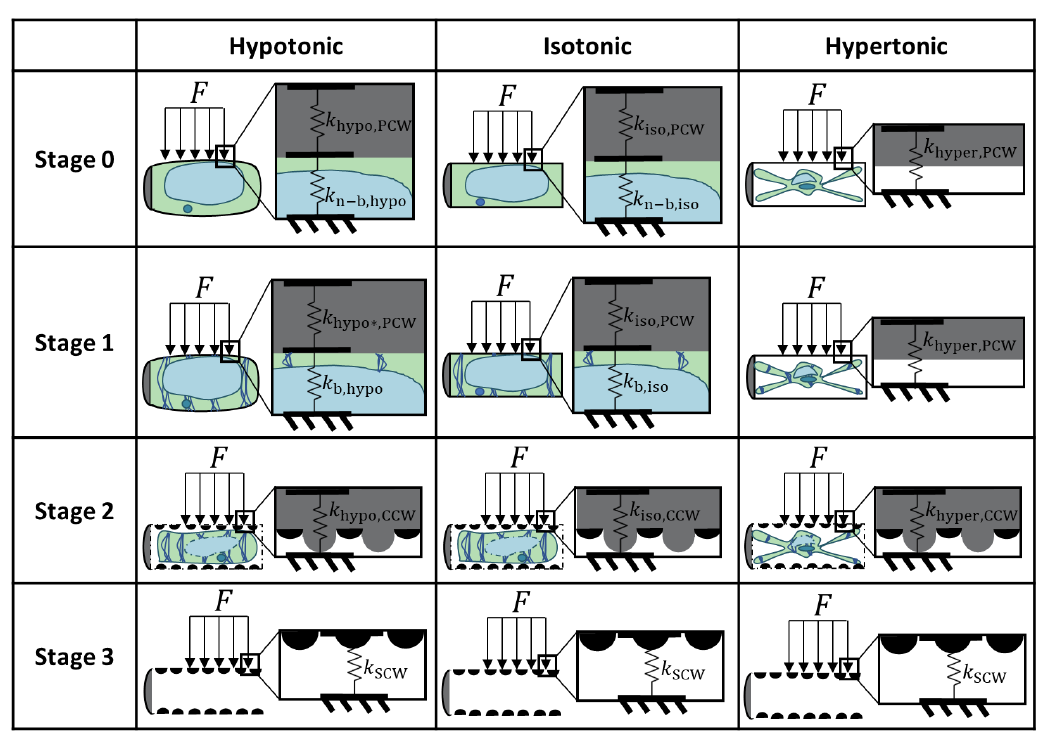
Figure A3. spring models for all treatments/stages.